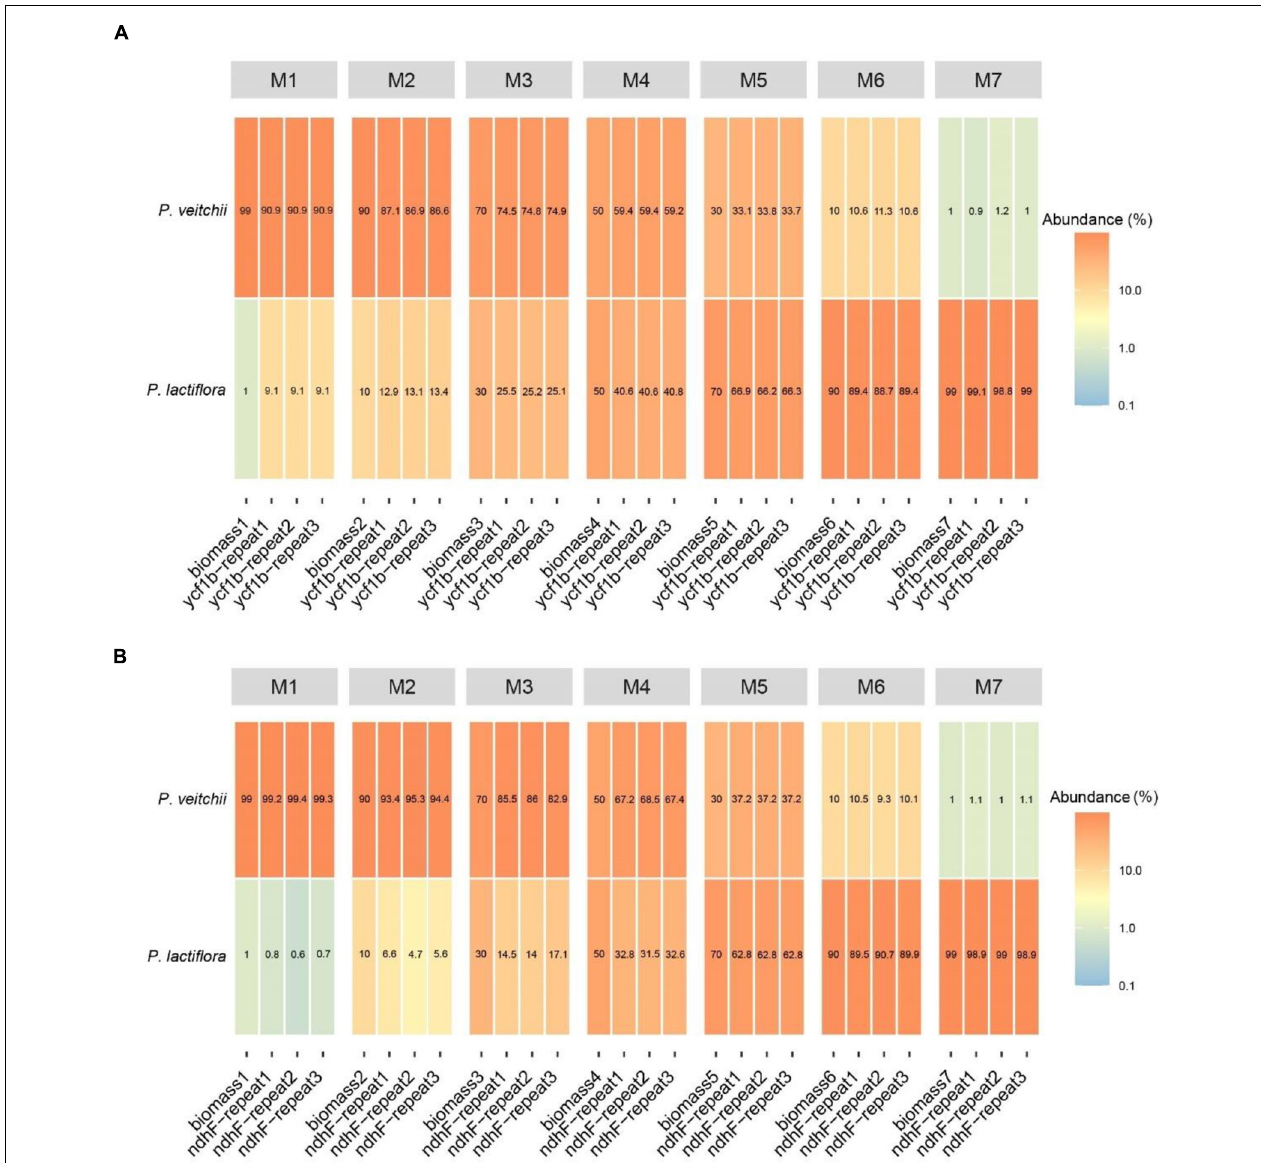
FIGURE 6 | Heatmap of reads abundance of two pairs of different primers in seven experimental mixtures (A) Primer CS -ycf1b ; (B) Primer CS -ndhF .